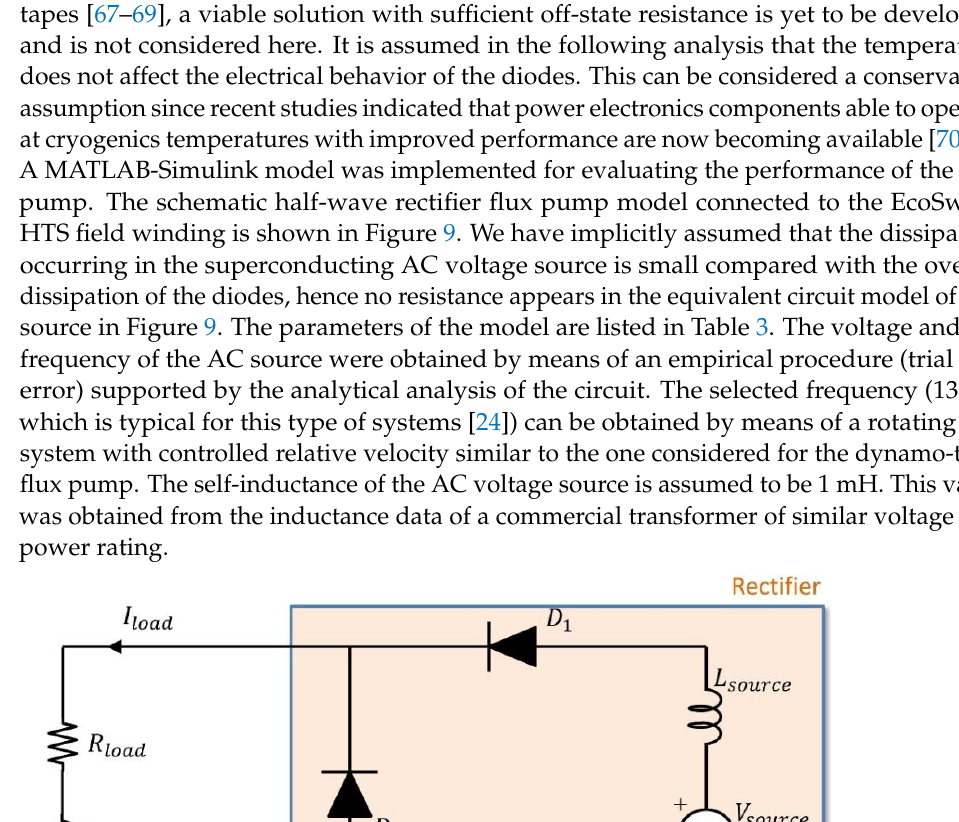
Figure 10. Contactless supply system of the rotor HTS field winding of the EcoSwing turbine, based on the warm rectifier flux pump.